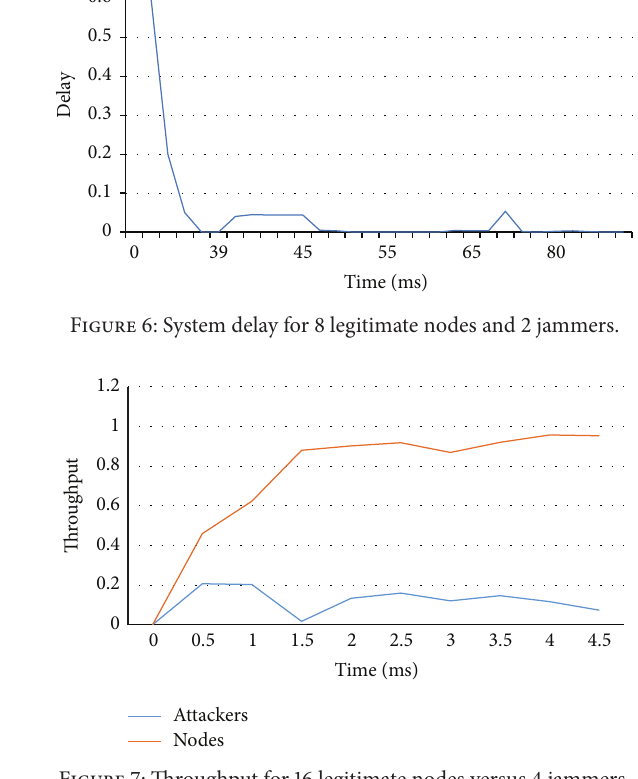
Figure 7: Throughput for 16 legitimate nodes versus 4